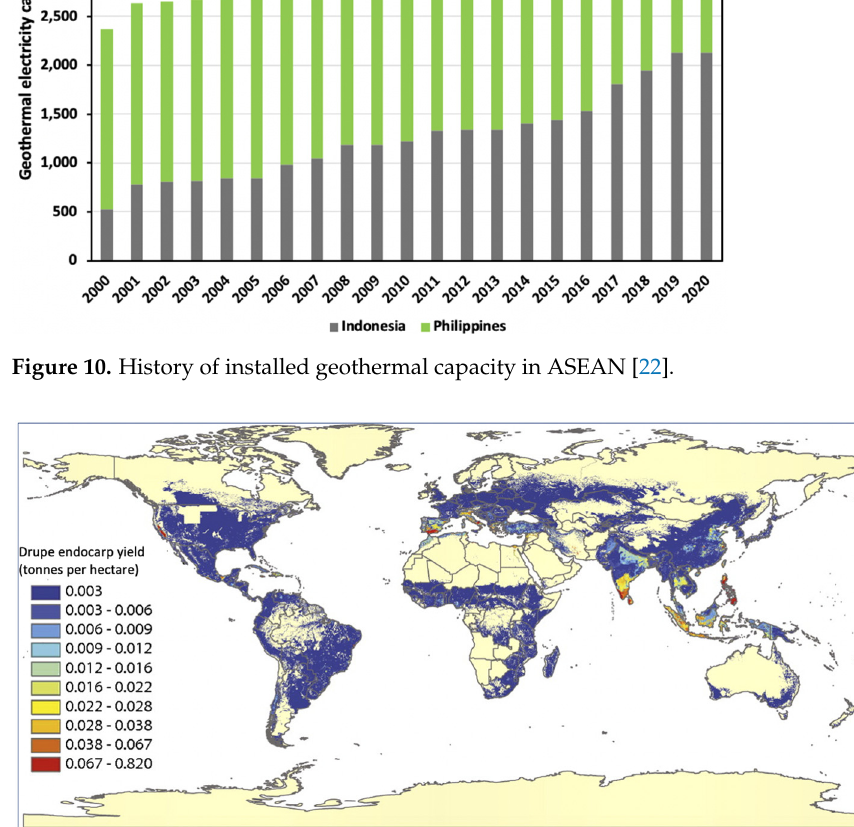
Figure 12. History of installed bioenergy capacity in ASEAN [22] . 3.1.7. Sustainability Issues with Bioenergy Most of ASEAN’s bioenergy comes from first-generation biocrops such as palm oil, sugarcane, coconut, and cassava. This creates substantial sustainability issues such as competition for land and water resources, food scarcity, loss of biodiversity, deforestation, destruction of peatland, greenhouse gas emission, soil erosion, rural development, social conflicts, and public health, among others [28]. Unless these issues are managed and min- imized, the future of bioenergy in ASEAN is called into question. The two major biofuels produced in ASEAN are biodiesel and bioethanol. Indone- sia’s biofuel industry mostly produces biodiesel made from palm oil. It is the world’s larg- est palm oil producer and its second largest exporter [29]. Similarly, Malaysia’s major bio- fuel product is biodiesel made from palm oil. Thailand produces both biodiesel from palm oil and bioethanol from sugarcane and cassava. Philippines produces biodiesel from co- conut oil and bioethanol from sugarcane. The three bioenergy powerhouses of ASEAN, namely, Thailand, Malaysia, and In- donesia, produce 59% (44.5 Mt), 25% (18.7 Mt), and 4% (3.1 Mt), respectively, of the world’s palm oil in 2021 [30]. Indonesia, Malaysia and Thailand export 66% (29.5 Mt), 87% (16.2 Mt), and 18% (0.55 Mt), respectively, of their palm oil, mostly to India, China, and the EU. Palm oil is a first-generation biocrop because it is a food crop [21]. It can be